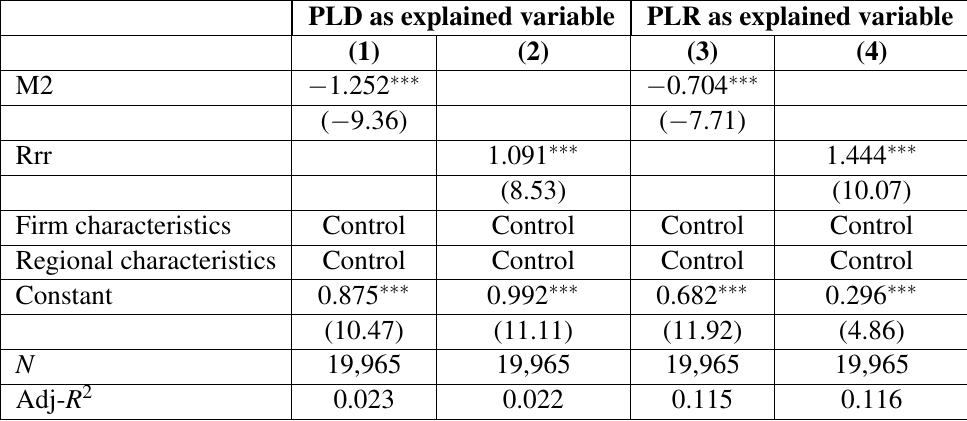
Table 4 Monetary policy and stock